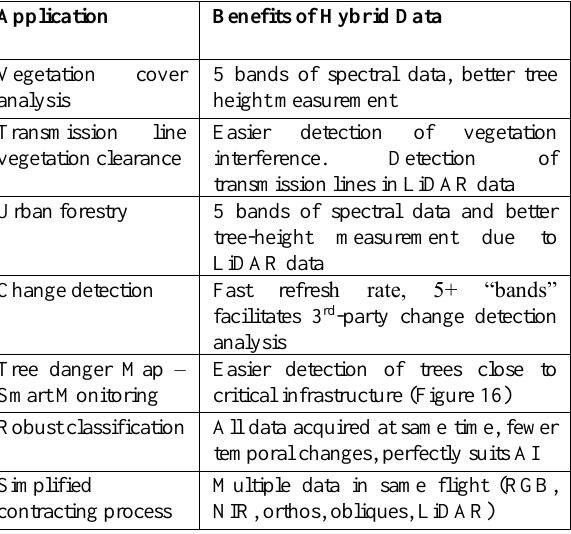
Table 4: Samples of new and enhanced products from hybrid